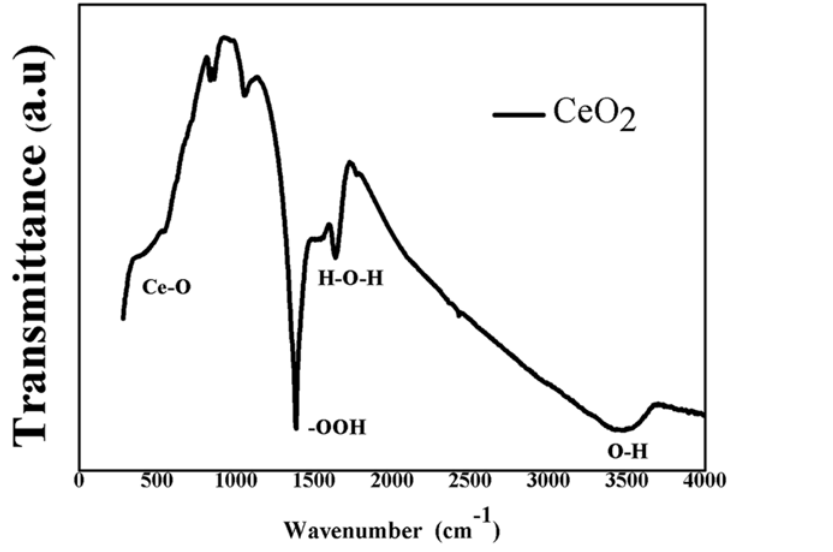
Fig 5. FT-IR spectrum of CeO 2 nanoparticle.